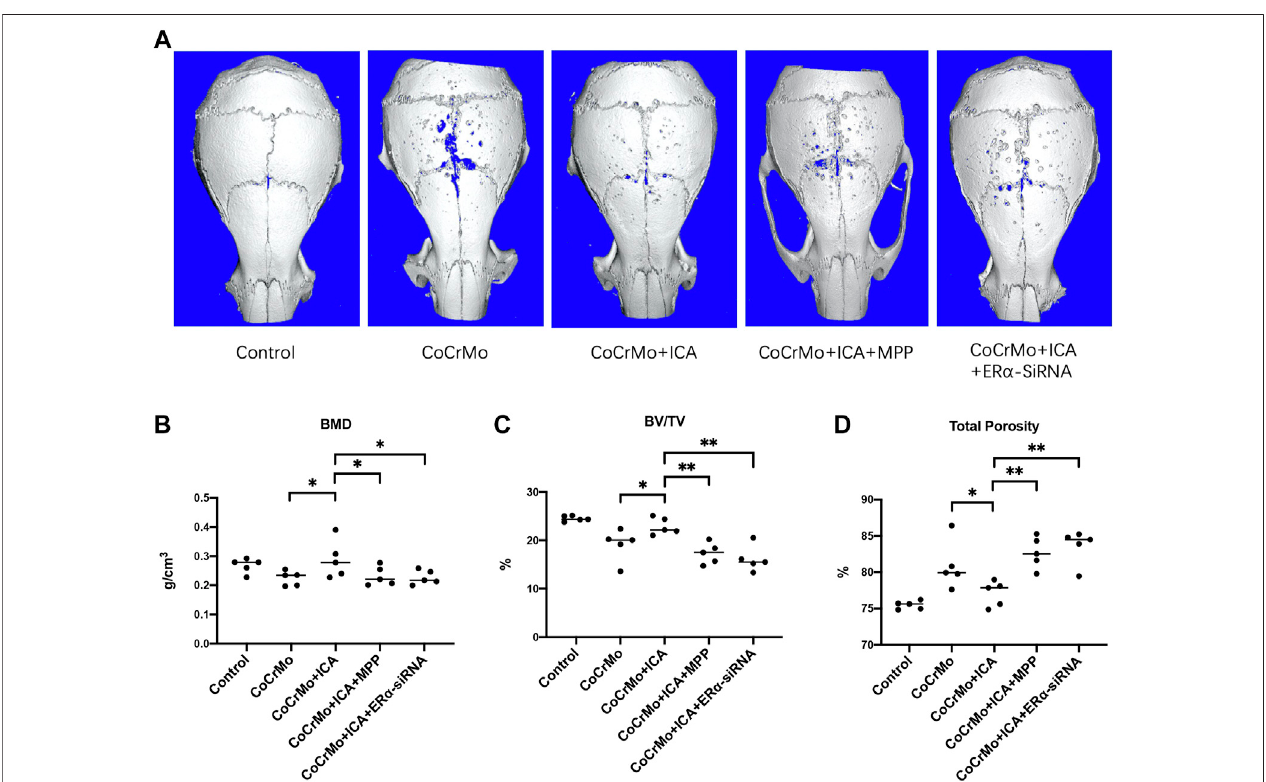
FIGURE 5 | The protective effect of ICA on CoCrMo particle-induced mouse calvarial osteolysis was regulated by ER α . (A) Representative 3D reconstruction imagesforeachgroup.Nosigni fi cantdifferencesinBMD (B ),BV/TV (C) ortotalporosity (D) werefoundbetweentheICAandcontrolgroups.TheprotectiveeffectofICA on BMD, BV/TV and total porosity were reversed by ER α antagonist and by ER α -siRNA interference (B – D) . * indicates p < 0.05, ** indicates p < 0.01, and *** indicates p < 0.001. There were fi ve C57BL/6J mice in each group.